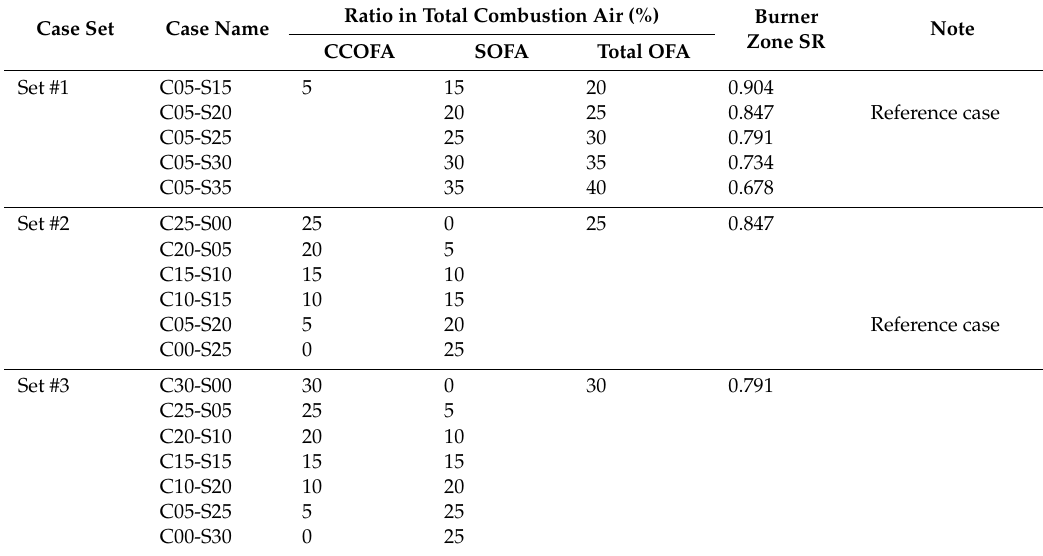
Table 2. Cases of various close-coupled overfire air (CCOFA) and separated overfire air (SOFA) ratios for computational fluid dynamics (CFD)